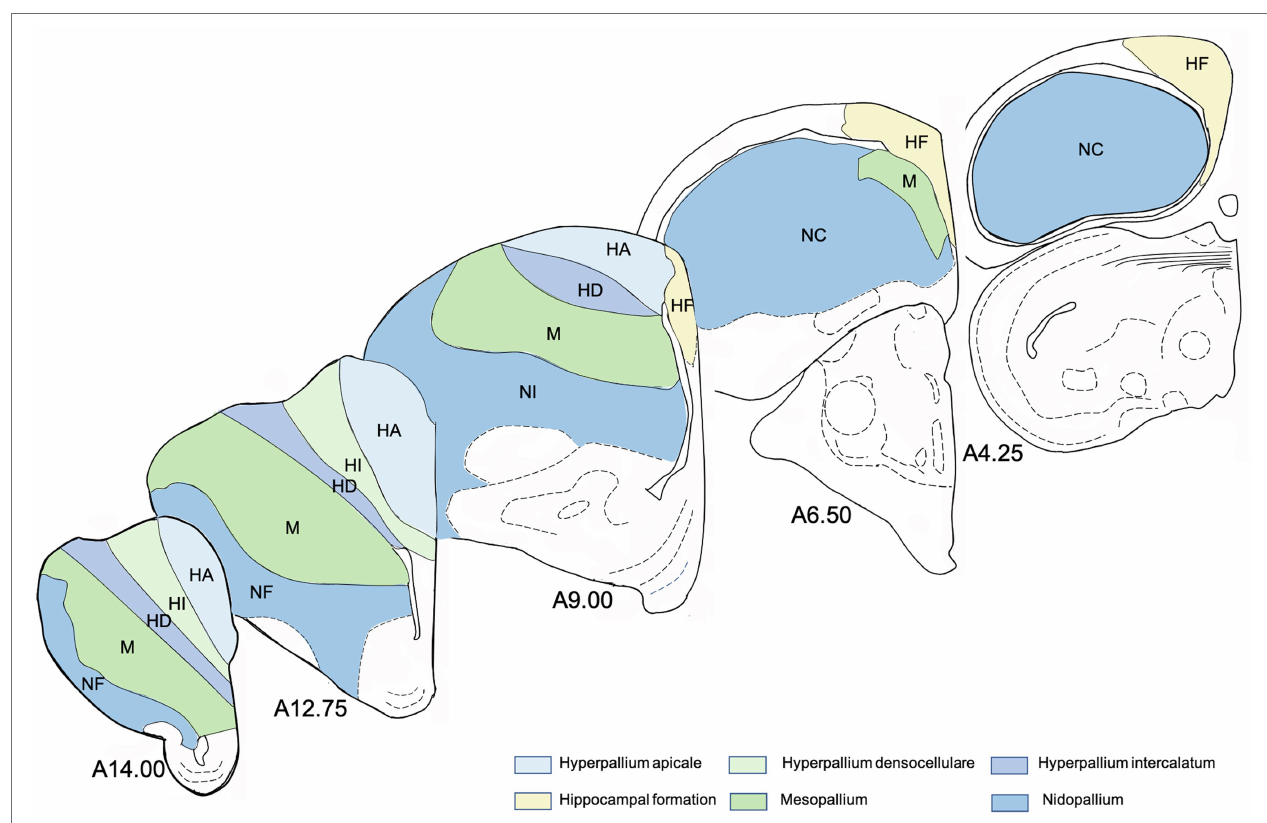
FIGURE 1 | Schematic drawings of representative coronal sections of pigeons’ brain left hemisphere, from anterior to posterior levels about analysed regions in the brain of the pigeon. Atlas levels referring to Karten and Hodos (1967). For abbreviations, see